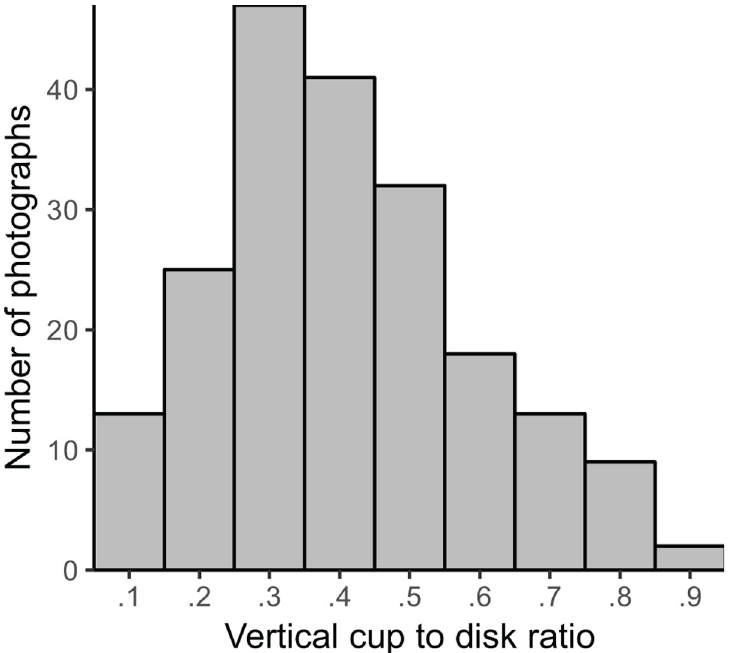
Fig 1. Distribution of reference standard vertical cup-to-disk ratio (VCDR) grades. The histogram shows the distribution of the median VCDR grade given by a group of 5 ophthalmologists on a set of 200 optic disk photographs.